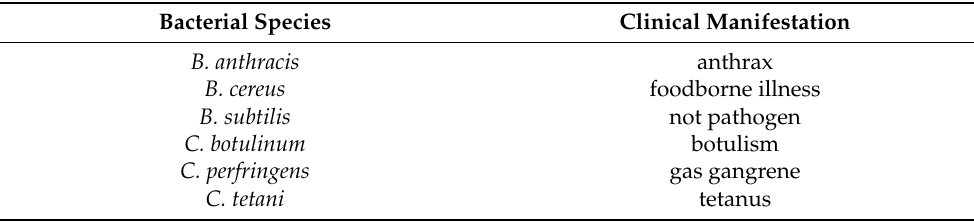
Table 1. Common endospore-producing bacteria and their clinical manifestations.